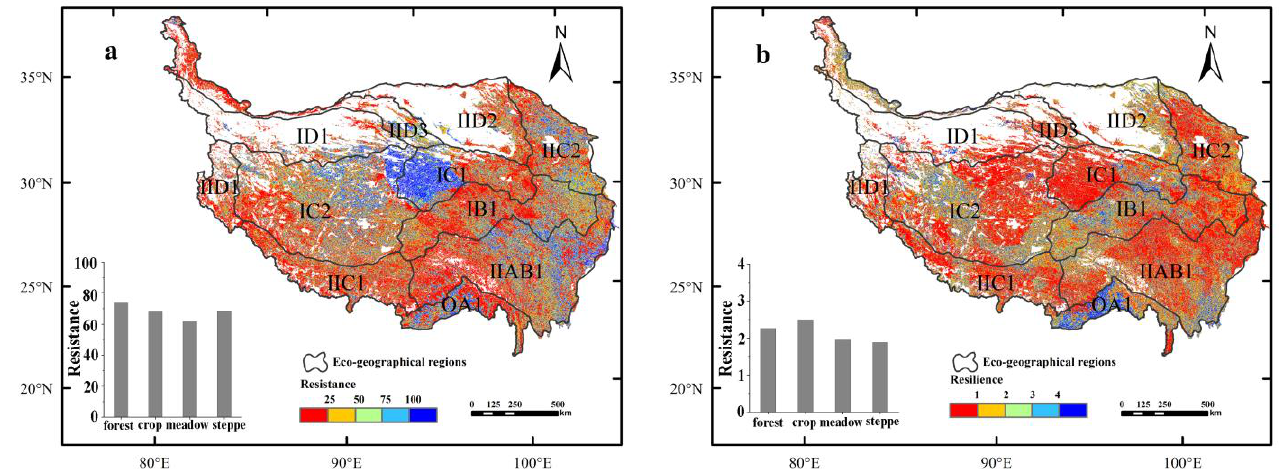
Figure 7. Spatial pattern of resistance ( a ) and resilience ( b ) of vegetation to drought and the differences in resistance and resilience between vegetation types on the QTP from 2000 to 2018.